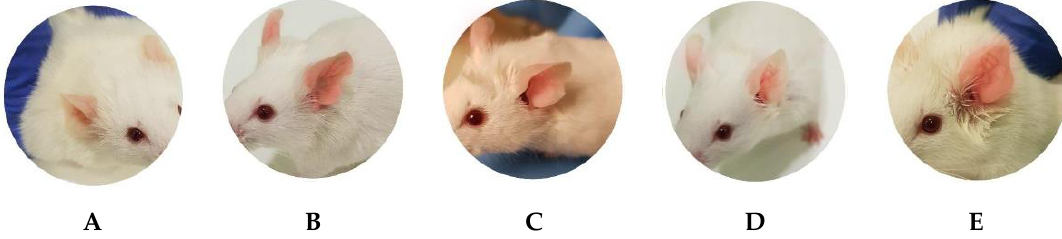
Figure 8. Macroscopic features of the ear’s appearance. ( A ) Negative control; ( B ) Positive control (edema and redness); ( C ) Ibuprofen group; ( D ) Apremilast microemulsion (APR-ME) group; and ( E ) Blank-ME group.